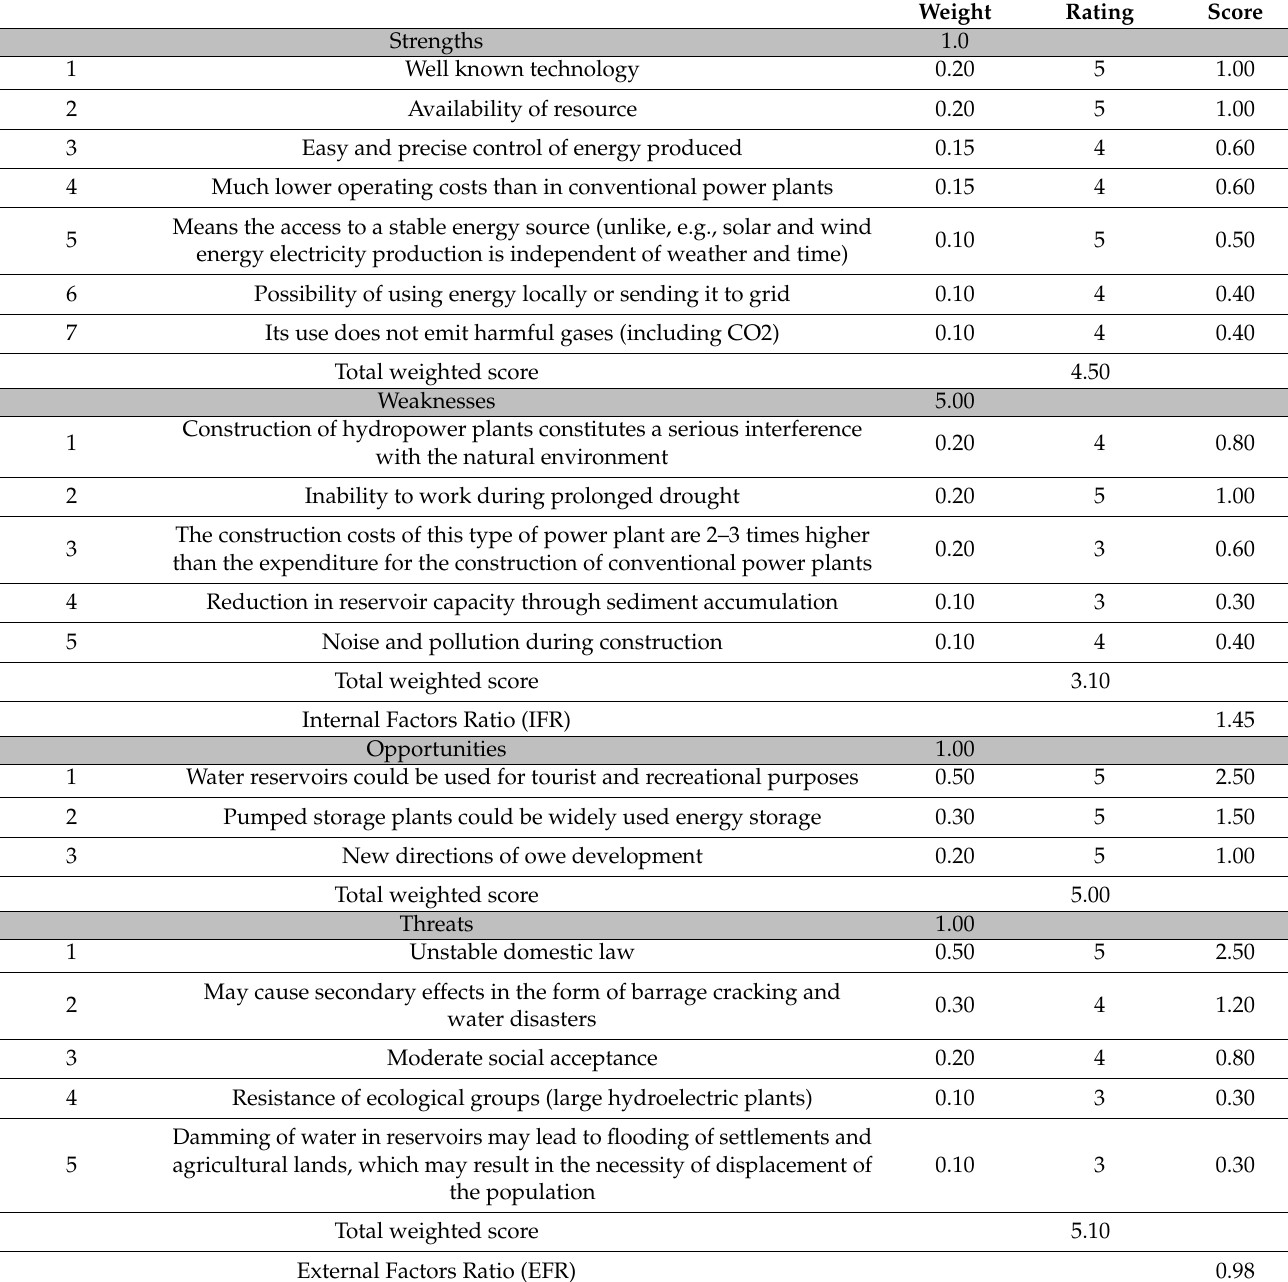
Table 6. Weighted SWOT analysis for hydropower systems in